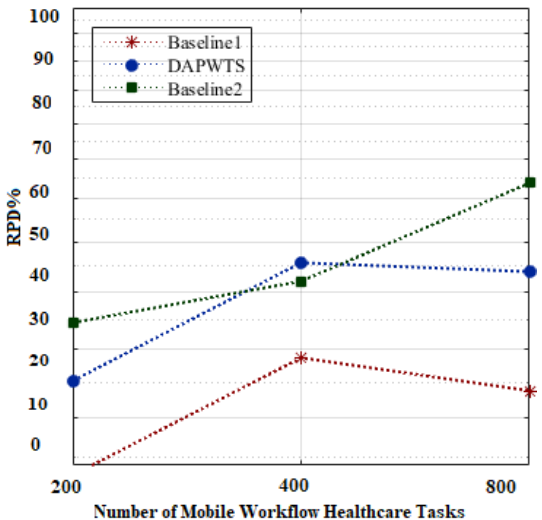
Figure 13. Failure energy-performance of tasks of applications